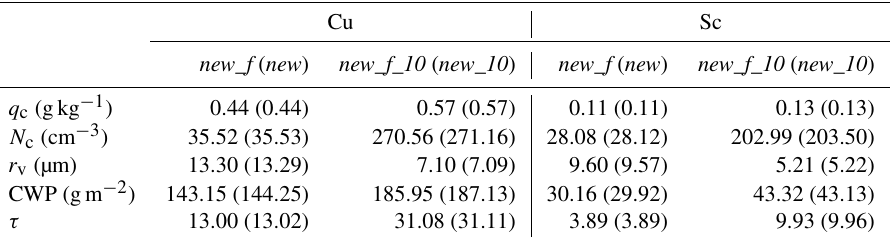
Figure 9. The temporal evolutions of main cloud microphysical and optical properties in all simulation experiments for the cumulus case, including (a) cloud water mixing ratio ( q c ) (gkg − 1 ), (b) cloud droplet number concentration ( N c ) (cm − 3 ), (c) cloud droplet volume mean radius ( r v ) (µm), (d) cloud water path (CWP) (gm − 2 ), and (e) cloud optical depth ( τ ). In (b) , N c values in the experiments default and new_f are normalized by the maximum cloud droplet concentration ( N cmax ) from default ; N c values in the experiments default_10 and new_f_10 are normalized by N cmax from default_10 ; new_f and new_f_10 are the experiments using entrained air relative humidity. Table 6. Cloud water mixing ratio ( q c ), cloud droplet number concentration ( N c ), cloud droplet volume mean radius ( r v ), cloud water path (CWP), and cloud optical depth ( τ ) in new_f and new_f_10 for the cumulus (Cu) and stratocumulus (Sc) cases. The results of new and new_10 in Tables 2 and 4 are shown in the